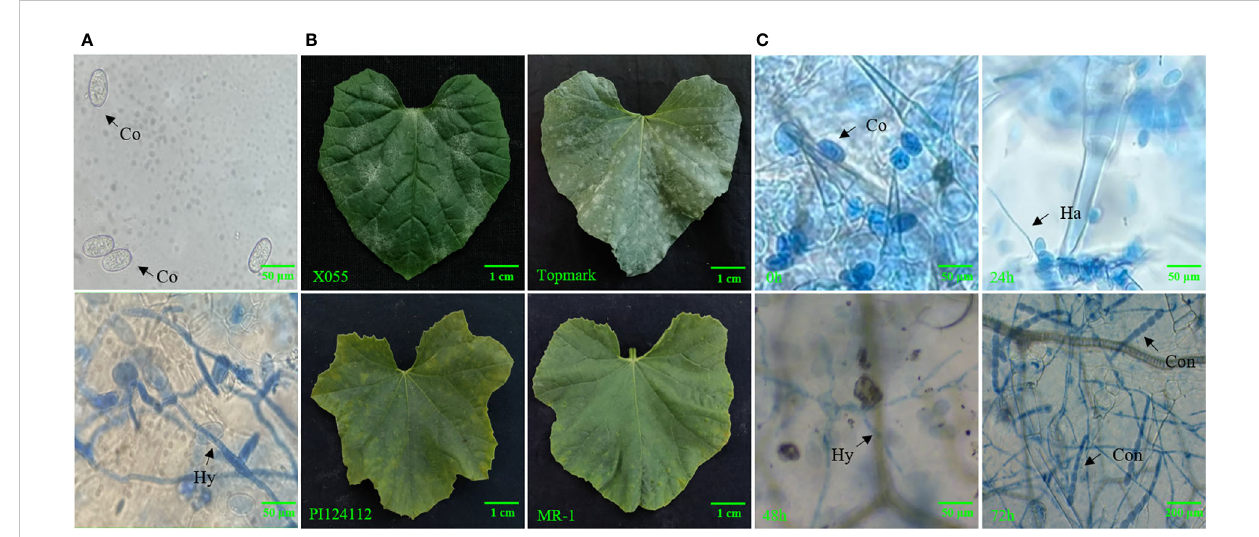
FIGURE 1 (A) Microscopic observation of morphology of PM-susceptible line (Topmark) infected with Podosphaera xanthii , (B) Phenotypic characteristics of PM-susceptible lines (X055 and Topmark) and PM-resistance lines (PI124112 and MR-1), (C) Fungal morphology of PM-susceptible line (Topmark) infected with by P. xanthii race 1 at different time interval. Co, conidium; Ha, haustorium; Hy, hyphae; Con,